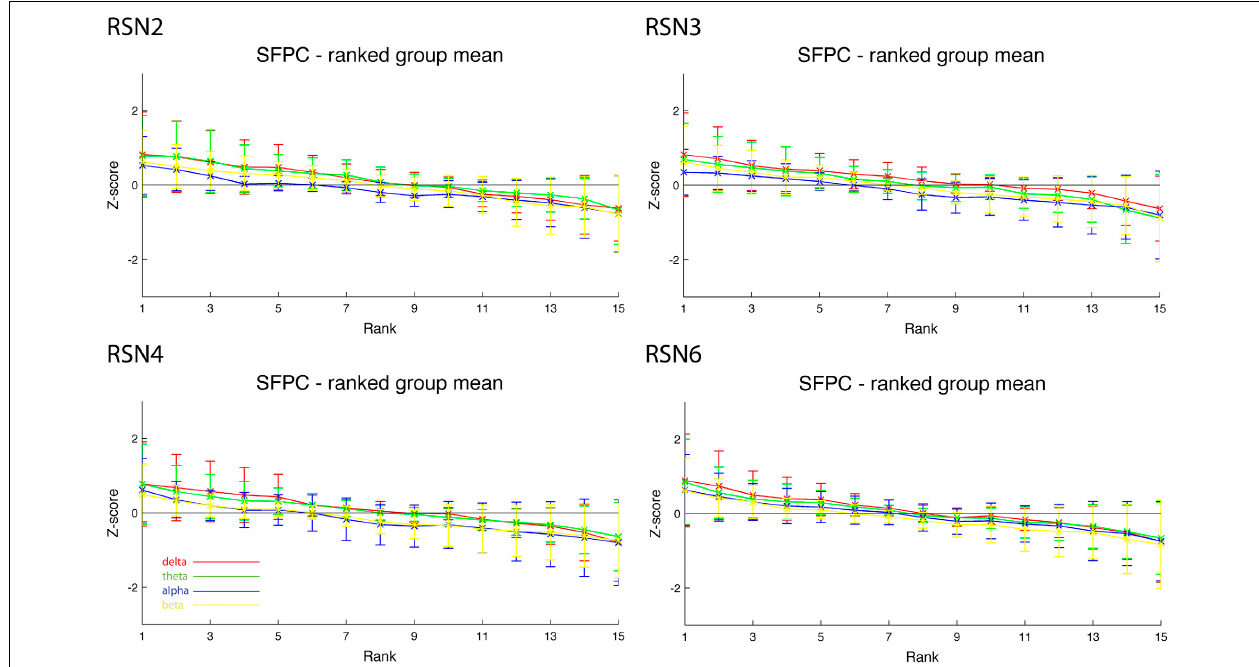
FIGURE 1 | Correction of Figure 5 of the original manuscript, showing only minor differences to the erroneous graphs in the original Figure 5. This reflects a similar inter subject and temporal variance independent of the change in dipole